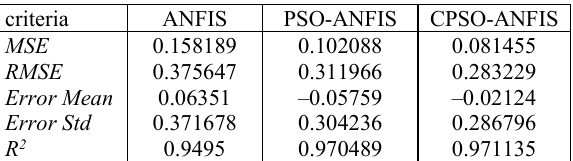
Table 6. The training and prediction results of the three models